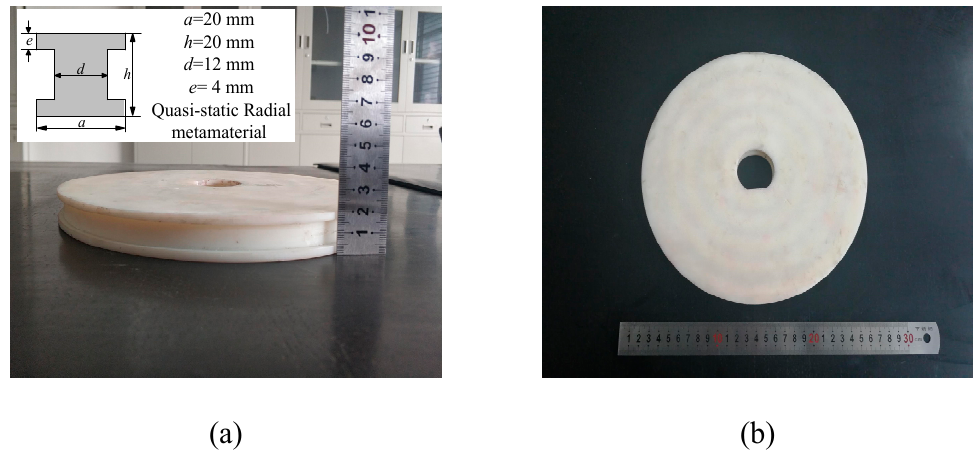
Figure 17. Experimental specimen of the I-shaped metamaterial plate: ( a ) side view and ( b ) front